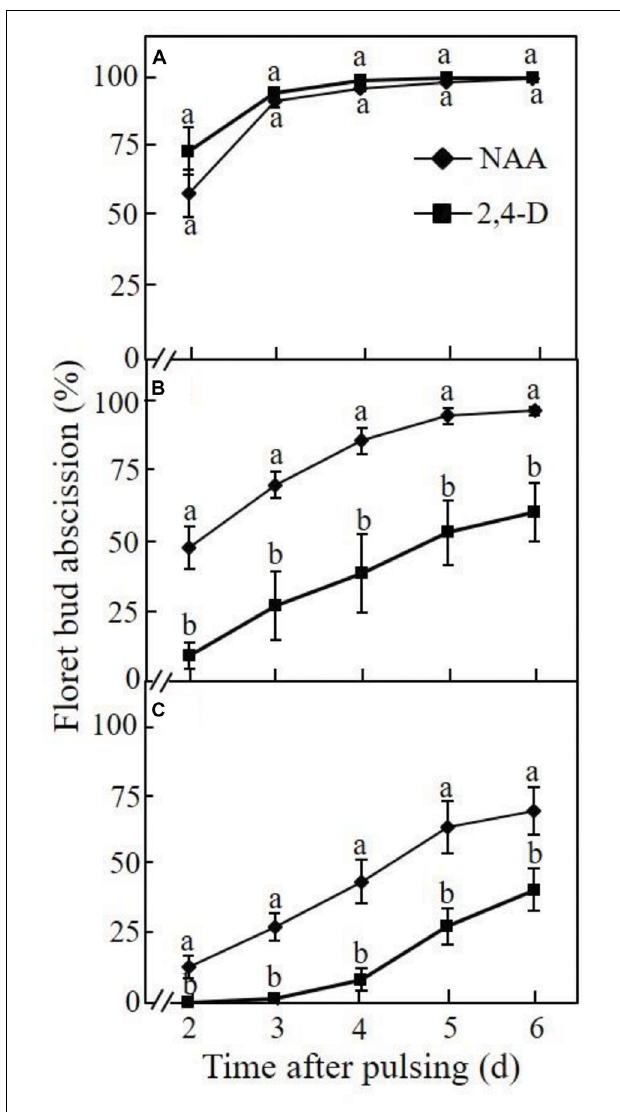
FIGURE 2 | Effect of the pH of the auxin pulsing solution on the efficacy of NAA and 2,4-D to retard floret bud abscission in Red Cestrum cut flowers during vase life. The cut flowers were pulsed for 24 h at 20 ◦ C with either 0.2 mM NAA or 2,4-D at pH = pKa (A) , pH = 7.0 (B) , or pH = 8.25 (C) and then placed in TOG-6 solution under vase life conditions for monitoring bud abscission. The percentage of abscised floret buds was determined relative to the total number of floret buds (abscised and intact) per inflorescence. Each value represents means of five replicates ± SE. Different letters indicate significant differences between treatments at each pH separately, at P ≤ 0.01 according to the Tukey–Kramer HSD test using one-way ANOVA. The pKa values of NAA and 2,4-D are 4.23 and 2.75, respectively.